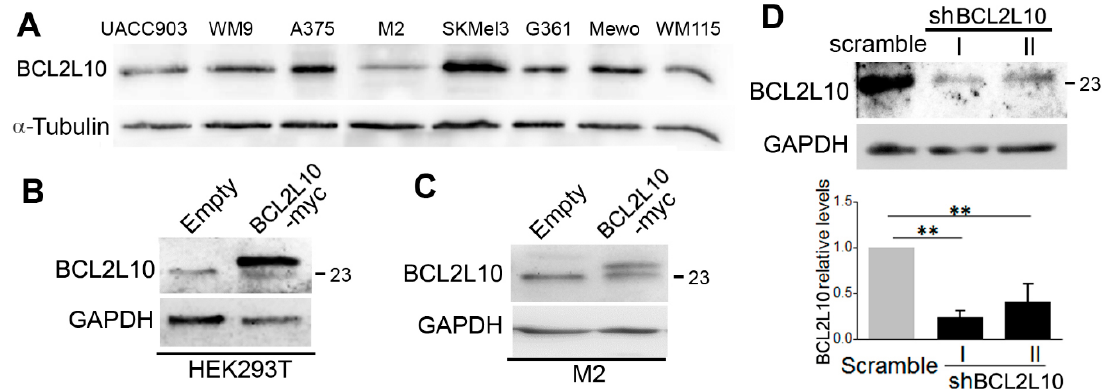
Figure 1. BCL2L10 expression in human melanoma cell lines and validation of BCL2L10 overexpression and silencing. ( A ) Protein extracts from the indicated melanoma cell lines were probed by Western blot with a 1:1000 dilution of the BCL2L10 antibody #3869. α -tubulin was used as the loading control. ( B ) Validation of the BCL2L10 antibody in HEK293 transfected with BCL2L10-myc. Protein extracts from HEK293T cells transfected with BCL2L10-myc or empty plasmid were assayed by Western blot using the anti-BCL2L10 PA5-22190 antibody (1:1000 dilution). ( C ) Validation of the BCL2L10 antibody in M2 cells stably transfected with BCL2L10-myc. Protein extracts from M2-empty and M2-BCL2L10-myc cells were assayed by Western blot using the PA5-22190 antibody (1:1000 dilution). ( D ) Silencing of BCL2L10 in A375 cells. Protein extracts from A375 cells transduced with two shRNA for BCL2L10 (I and II) or a scramble shRNA were analyzed for BCL2L10 expression by Western blot using the PA5-22190 antibody (1:1000 dilution). Bar graphs show the mean ± SD (from three independent experiments) of BCL2L10 levels normalized to the loading control and expressed as the fold change relative to scramble cells. The statistical analysis is described in Methods. **: p < 0.01, n = 3. α -tubulin was used as a loading control in panel A and GAPDH in panels B-D. The blots displayed in all panels are representative of three independent experiments. The 23 kDa marker is indicated in panels ( B – D ). Whole Western blot figures provided in Supplemental Materials Figure S1.